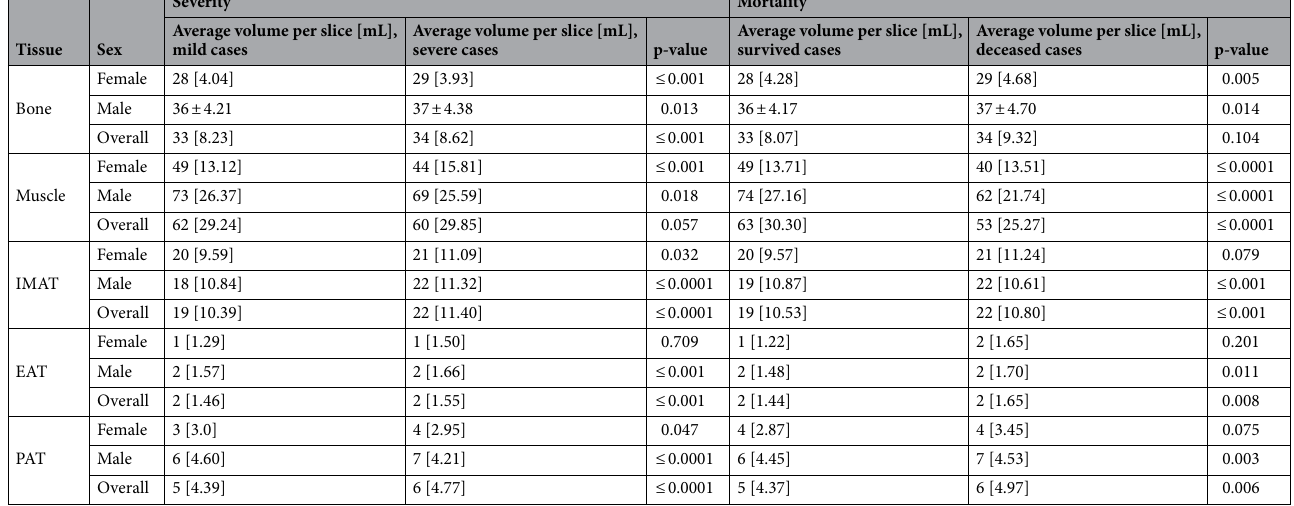
Table 2. Overview of the median volume [IQR] and p-values of the normalized BCA-Features (per slice) within both endpoint categories severity and mortality. Only the male average bone volume per slice was normally distributed and thus is reported as mean and SD. The p-values were calculated using the Mann– Whitney-U test IMAT: intra- and intermuscular adipose tissue, EAT: epicardial adipose tissue, PAT: pericardial adipose